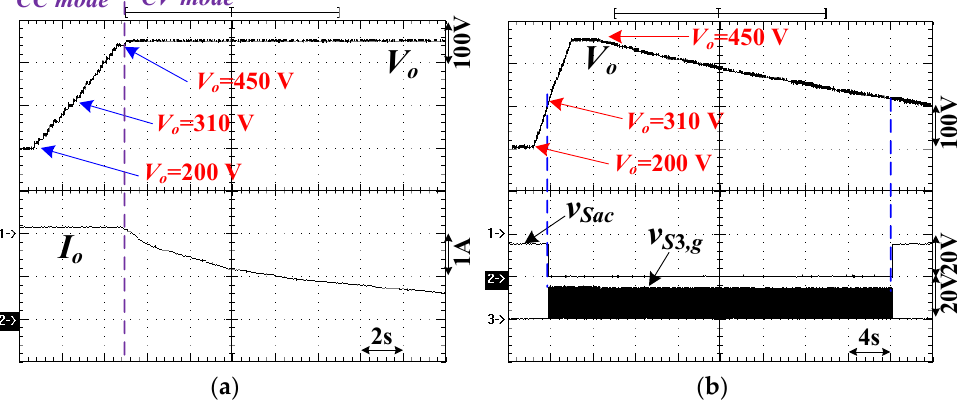
Figure 10. Measured waveforms ( a ) V o and I o under constant current (CC) mode and constant voltage (CV) mode control; ( b ) V o , v Sac , and v S 3, g .